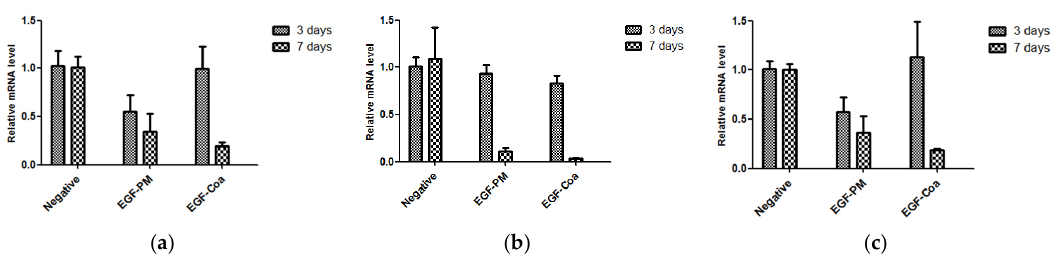
Figure 5. Proinflammatory cytokine levels. ( a ) IL-6, ( b ) IL-1, and ( c ) TNF- α in the wound area of STZ-induced diabetic mice after treatment with EGF-PM and EGF-Coa. 3 days: Negative, n = 3; EGF-PM, n = 4; EGF-Coa, n = 4. 7 days: Negative, n = 3; EGF-PM, n = 3; EGF-Coa, n = 2.